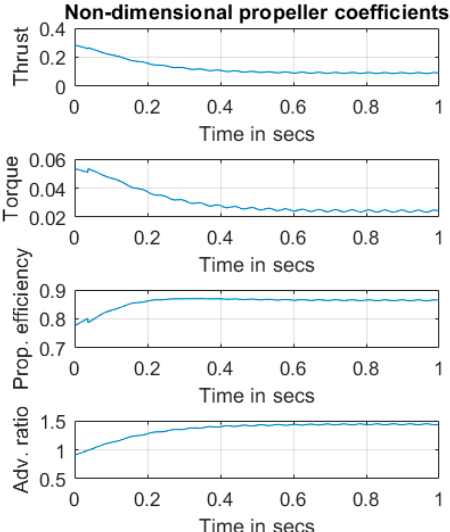
Figure 6. Variation of the HTS PMSM-driven propeller non-dimensional coefficients of thrust and torque, propulsive efficiency, and advance ratio as a function of time over the timeframe of 1 s at the superconducting temperature.